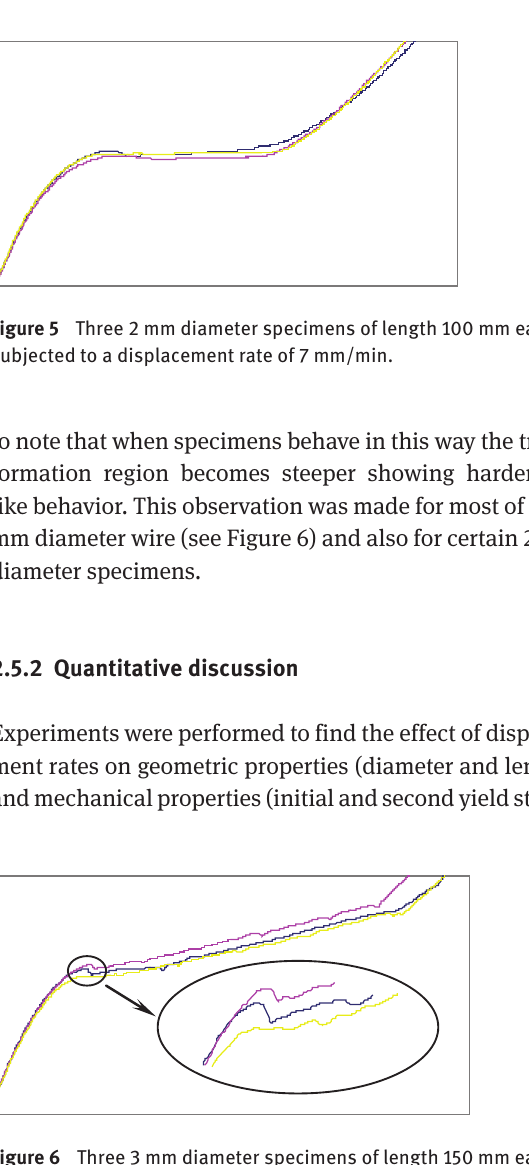
Figure 3 Effect of displacement rate on 2 mm diameter wire of length 250 mm. (A) 2 mm/min, (B) 4 mm/min and (C) 10 mm/min.